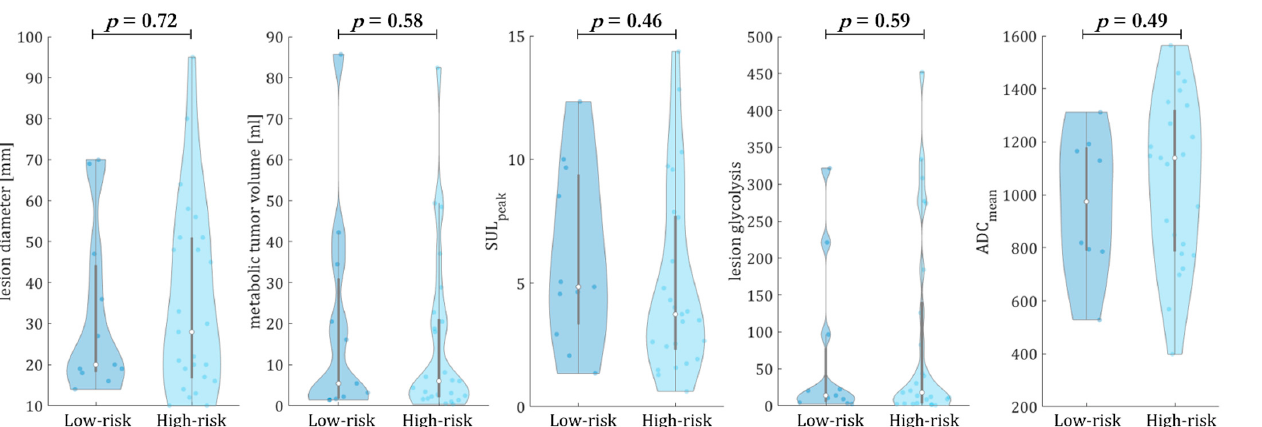
Figure 5. Analysis of CNN-based risk stratification in relation to clinical extracted parameters of the primary target lesions: lesion diameter, metabolic tumor volume, maximal standardized uptake value normalized by lean body mass (SULpeak), primary target lesion glycolysis and apparent diffusion coefficient (ADCmean). The CNN estimated the risk of the patients for treatment failure. No clinical parameter correlated statistically significantly with the predicted groupings into low- and high-risk groups obtained from the CNN, from which we concluded that the imaging-derived features and the lesions’ textural composition primarily determined the prediction.